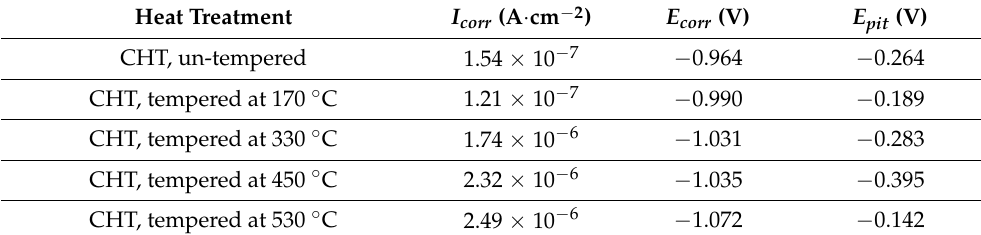
Figure 8. Potentiodynamic polarisation curves of CHT Vanadis 6 steel in un-tempered state and in the states after different tempering treatments. Table 4. Corrosion current, I corr , corrosion potential, E corr , and pitting potential, E pit , values acquired from corrosion tests in 3.5 mass % NaCl water solution, for CHT and differently tempered